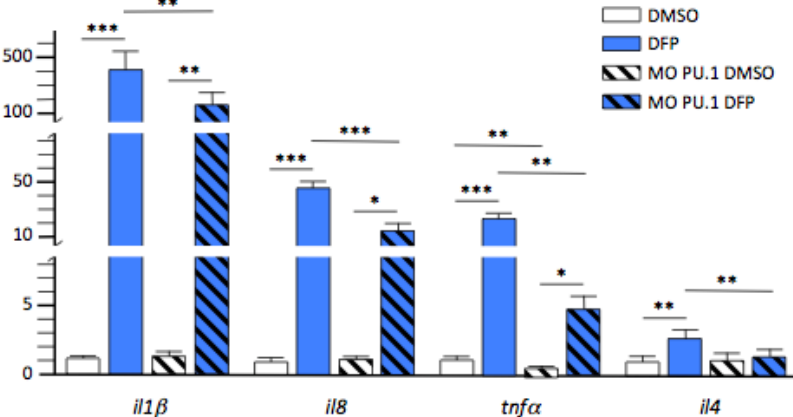
Figure 6. Microglia are key players in DFP-induced inflammation. Expression levels of transcripts encoding cytokines Il1 β , Il8 , Il4, and Tnf α relative to that of reference tbp transcripts, from control larvae and pU.1 morphants exposed for 6 h to either 1% DMSO (DMSO) or 15 µM DFP (DFP) (in each condition, N = 7–8 samples, n = 7 larvae/sample). Error bars on all graphs represent the standard error of the mean (SEM). Only statistically significant differences between samples are shown: *, p < 0.05; **, p < 0.01; ***, p < 0.001.